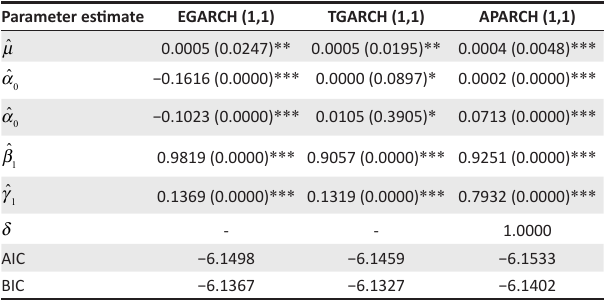
TABLE 2: Maximum likelihood parameter estimates of asymmetric generalised auto-regressive conditional heteroscedasticity models. Parameter estimate